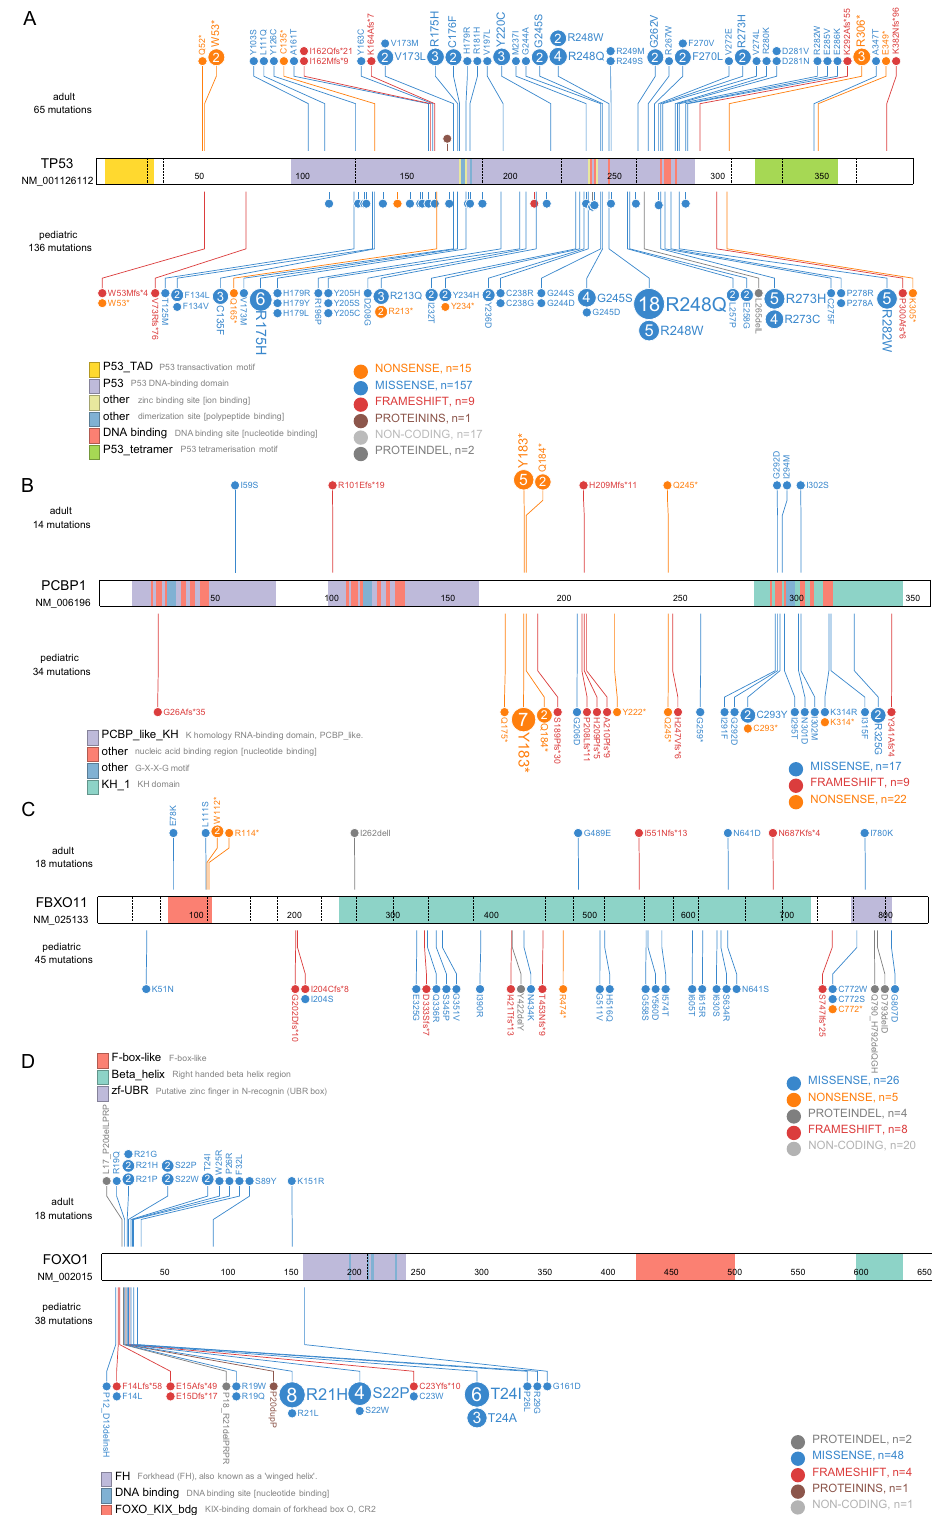
FH Forkhead(FH), also known as a 'winged helix'. DNA binding DNA binding site [nucleotide binding] FOXO_KIX_bdg KIX-binding domain of forkhead box O, CR2 FOXO-TAD Transactivation domain of FOXO protein family Fig. 6 Mutational overview of TP53 , PCBP1 , FBXO11, and FOXO1 at the amino acid level in the adult (top) and pediatric (bottom) cohort. A TP53 shows an accumulation of known hotspots at R175, R248, R273, R282, and G245 as found in other malignancies. B PCBP1 shows a hotspot truncation mutant (Y183*) identi fi ed in both age groups. C FBXO11 alterations are unique except for W112*. Most mutations were found in the β -helix domain. D In total, 7 4% of all pediatric FOXO1 mutations span the Akt phosphorylation motif on R19, R21, and T24. Exon boundaries are indicated using dashed lines.